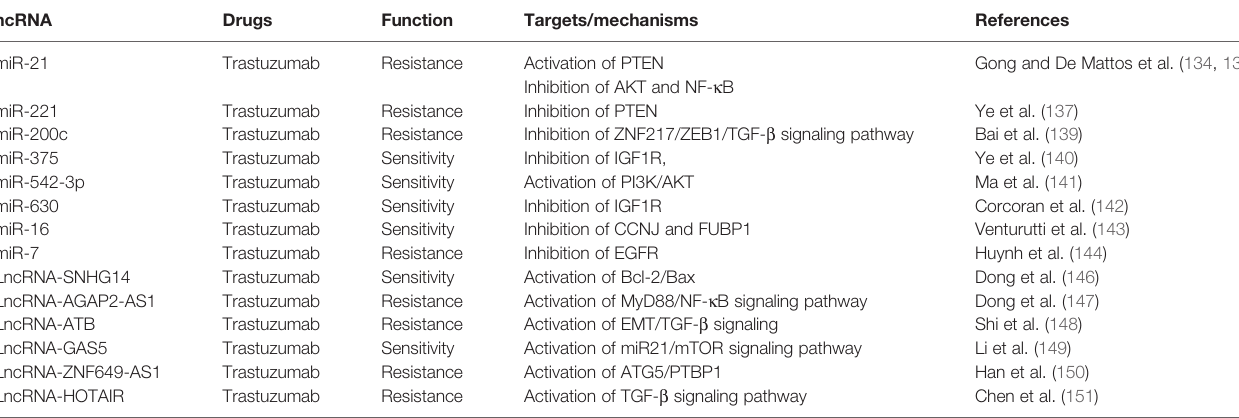
TABLE 6 | Breast cancer trastuzumab chemoresistance-related